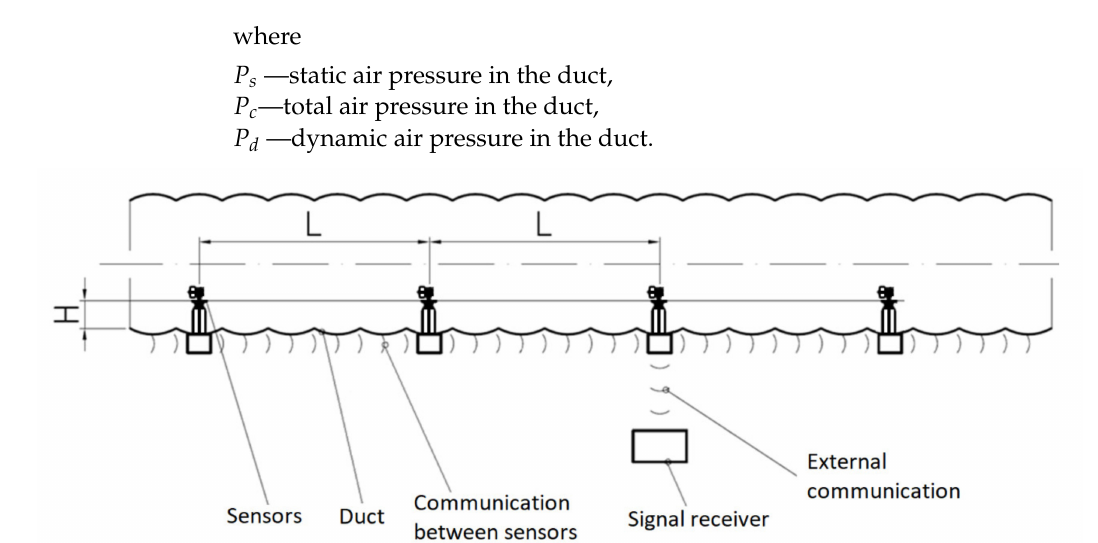
Figure 3. The concept of a ventilation leak detection system.